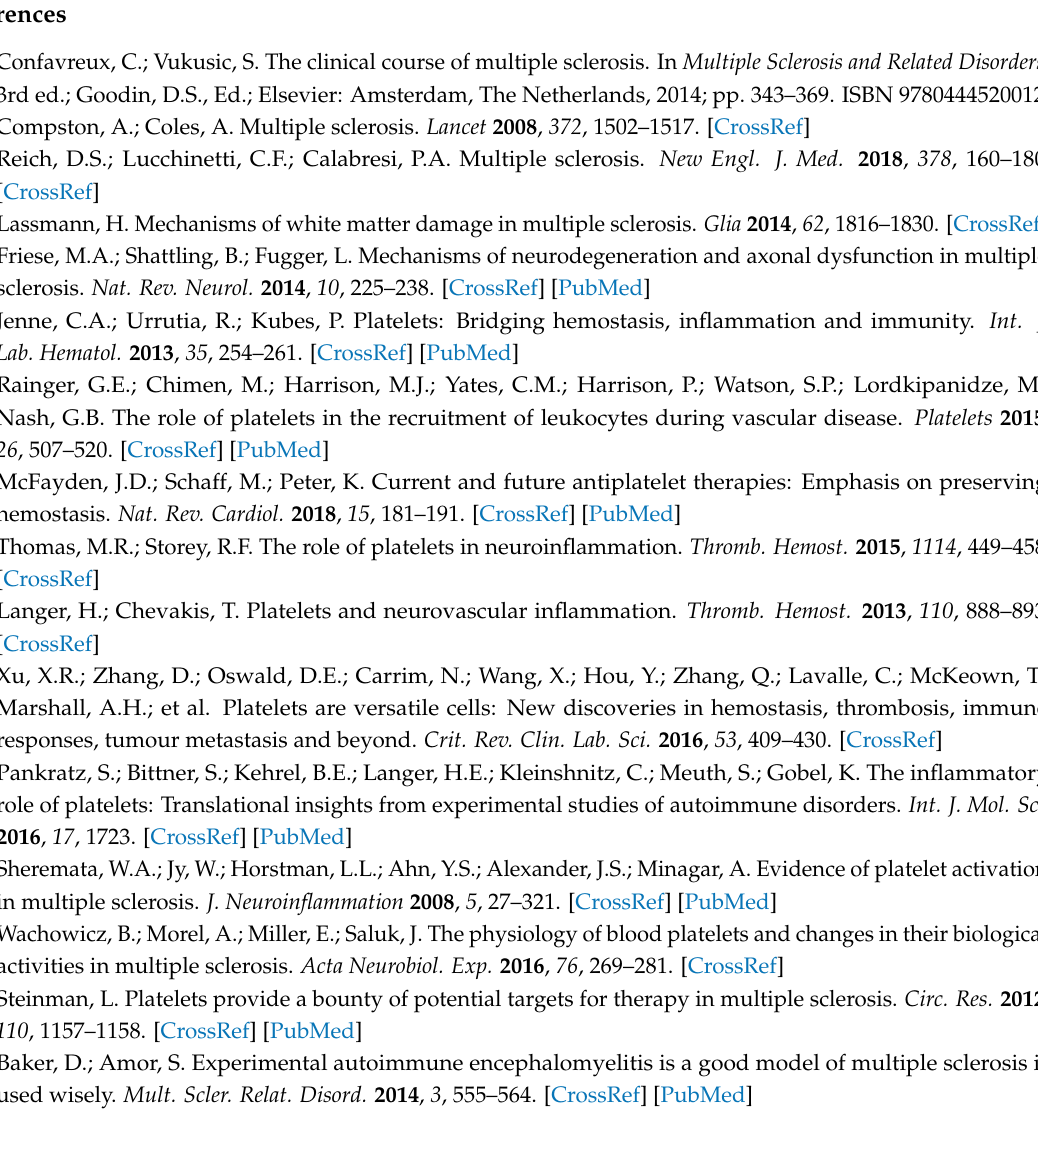
Table S1: The main effects and interaction effects of the two parameters under investigation, on plasma platelet counts per µ L. Table S2: The main effects and interaction effects of the two parameters under investigation, on the percentage of total time spent in open arms of the EPM. Table S3: The main effects and interaction effects of the two parameters under investigation, on locomotor